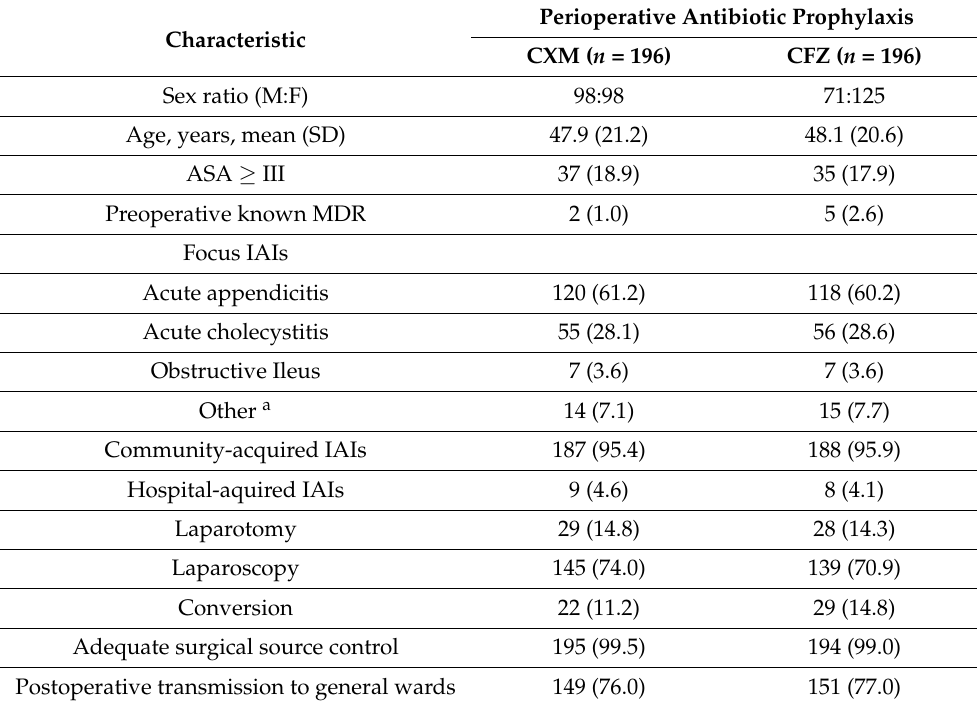
Table 3. Preoperative patient characteristics and intraoperative findings after propensity score